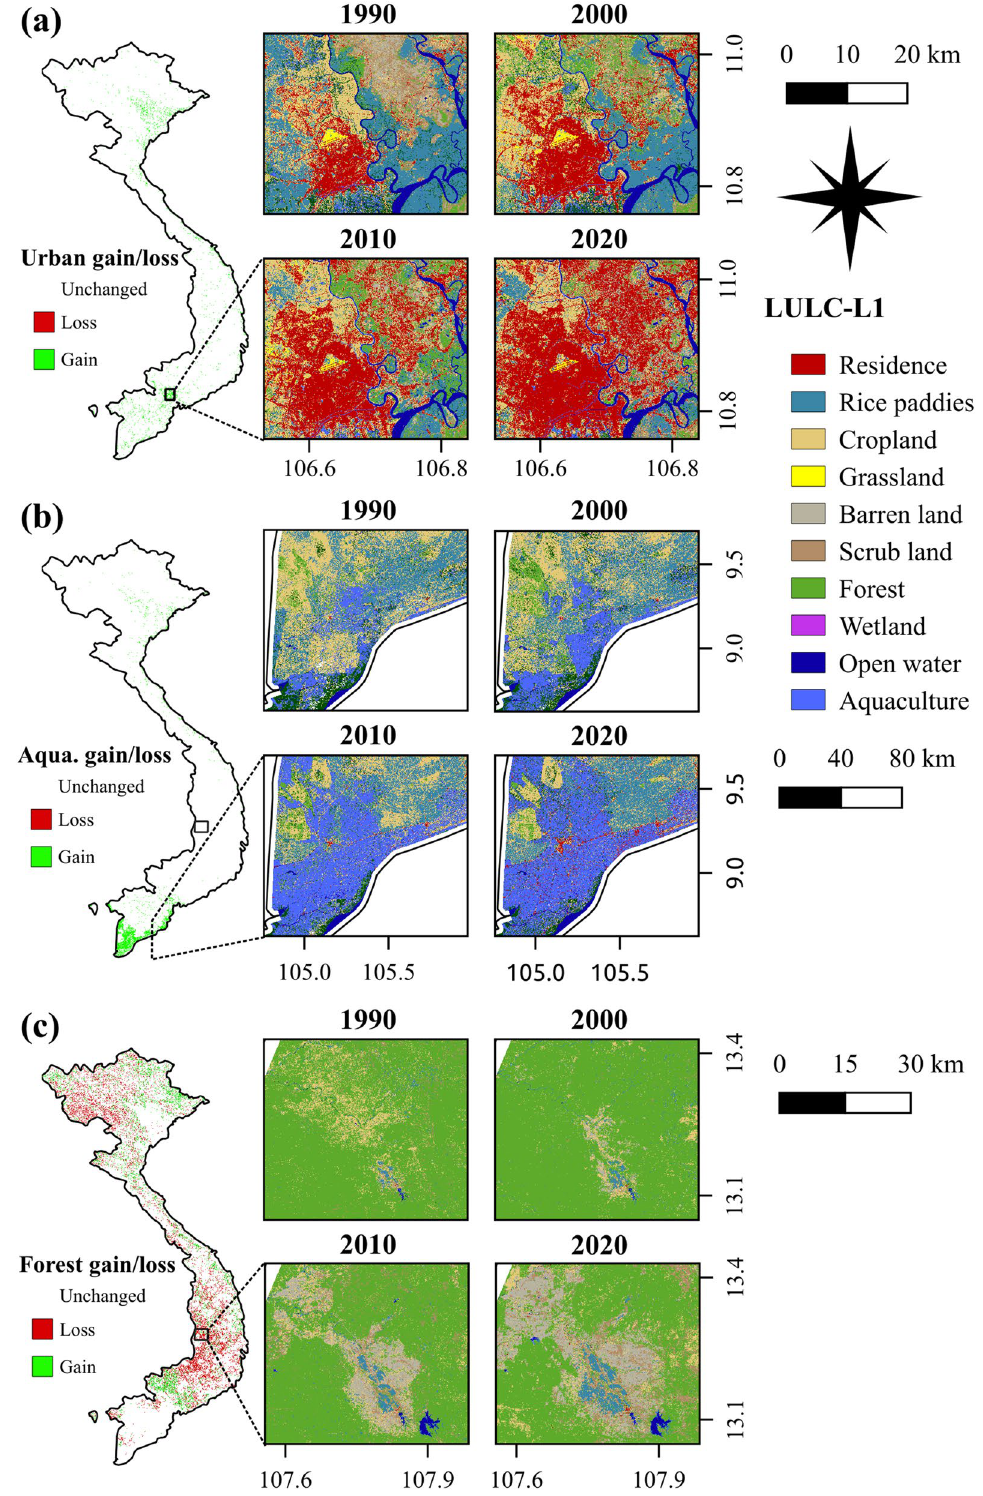
Figure 9. Spatial–temporal dynamics (left) and change pattern (right) of LULC in ( a ) residential land, ( b ) aquaculture land, and ( c ) forests land in Vietnam. This figure is generated using QGIS 3.18.0-Zurich (https:// qgis. org/ en/ site/) while the country boundary is extracted from the GADM (https:// gadm. org/ about.